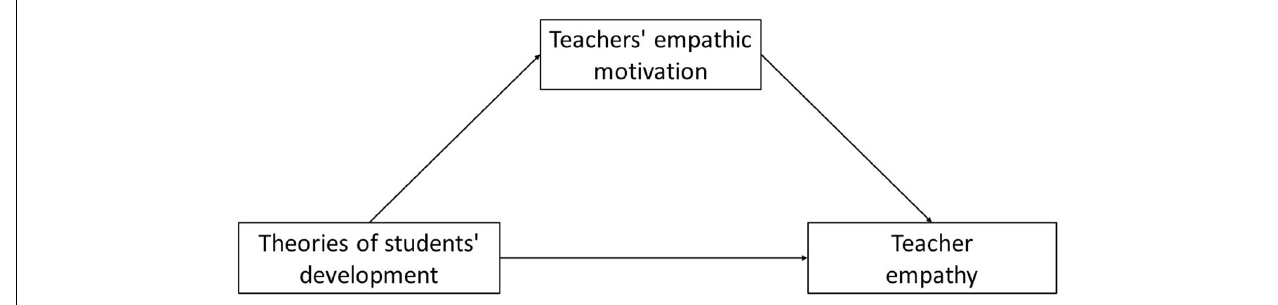
FIGURE 1 | The conceptual model of the relationships between teachers’ beliefs about Students’ development, teachers’ empathic motivation, and teacher empathy.